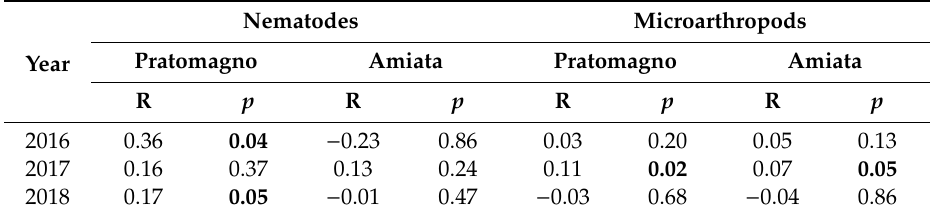
Figure 2. MDS analysis based on Bray–Curtis similarity index of nematode community abundance from soil samples in 2016, 2017, and 2018 in Pratomagno and Amiata sites. Stress tests (S) are reported. Symbols represent different managements: TB (thinning from below) in dark green; ST (selective thinning) in hell green; CTR (control without thinning) in brown. Table 2. General analysis of similarities (ANOSIM) result table for nematode and microarthropod abundances in the Pratomagno and Amiata sites from 2016 to 2018 (post-treatment). Significant values are reported in